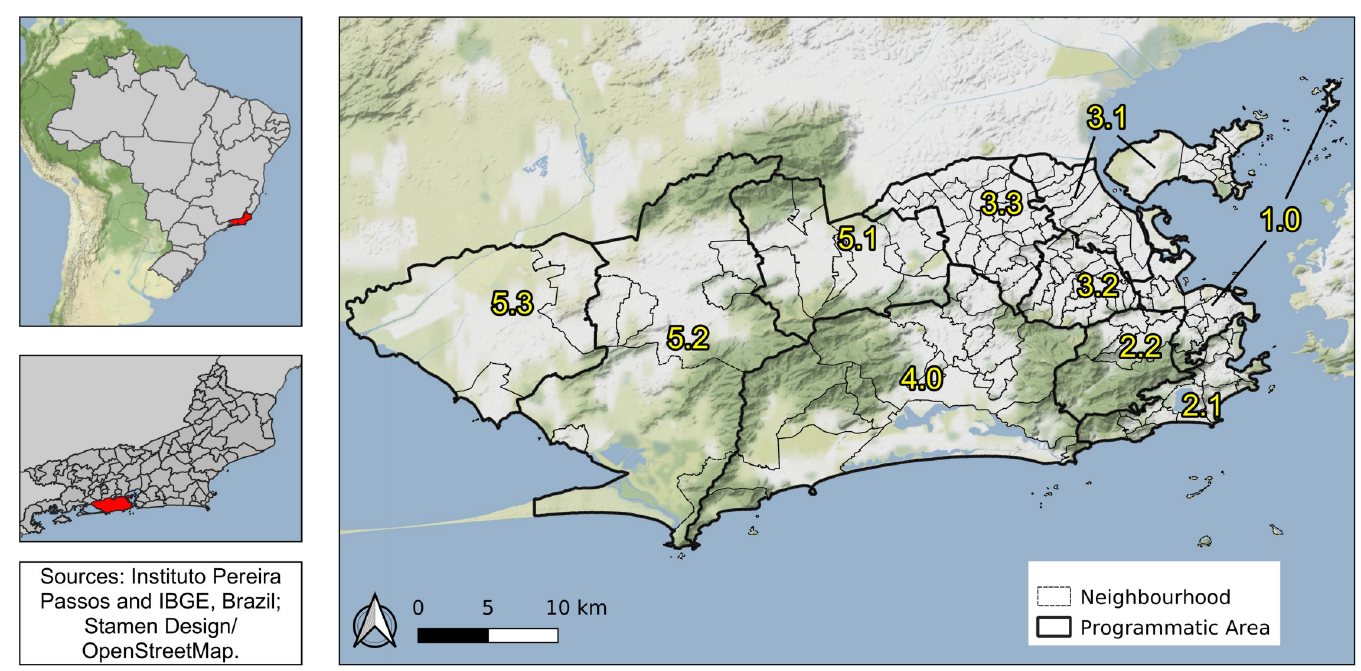
Fig 2. Rio de Janeiro city by programmatic areas and neighbourhoods, 2010, Brazil. Map created using QGIS version 3.12. Map layers by Instituto Pereira Passos (https://www.data.rio/) and Instituto Brasileiro de Geografia e Estatı´stica (https://www.ibge.gov.br/). Map tiles by Stamen Design (http://maps.stamen.com/), under CC BY 3.0. Data by